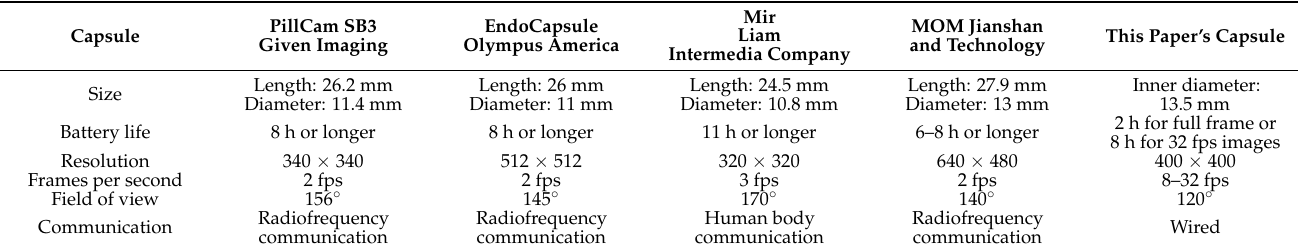
Table 1. Comparison between our capsule and others.